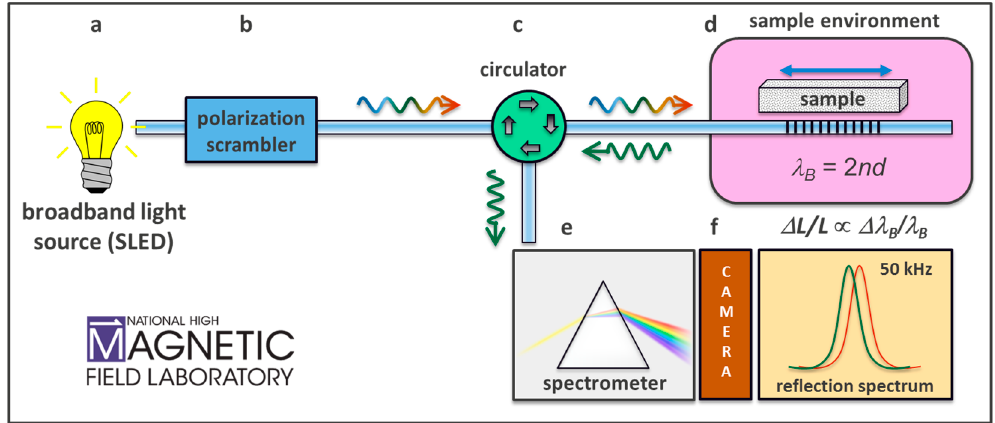
Figure 3. Experimental setup for high magnetic field FBG-based dilatometry implemented at the National High Magnetic Field Laboratory ( a ) Superluminescent broadband light emitting diode, operating in the 1500–1600 nm range. ( b ) Polarization scrambler. ( c ) Circulator. ( d ) Sample environment, in our case cryogenic temperatures to 0.5 Kelvin, and magnetic fields to 100 T. ( e ) Spectrometer and InGaAs line array combo, operating to 46 kHz. λ B is the Bragg wavelength, n is the fiber’s index of diffraction, and d is the grating spacing.